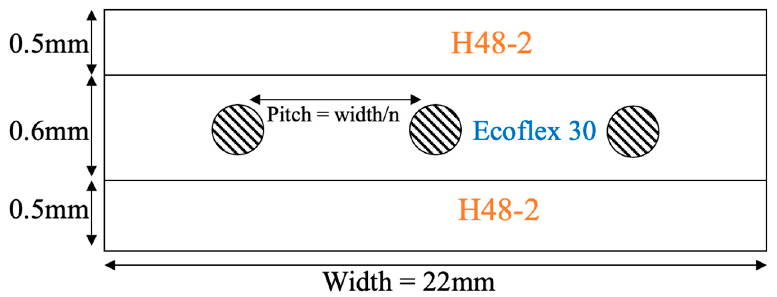
Figure 2. Cross section of the geometry studied in the transient thermal analysis.